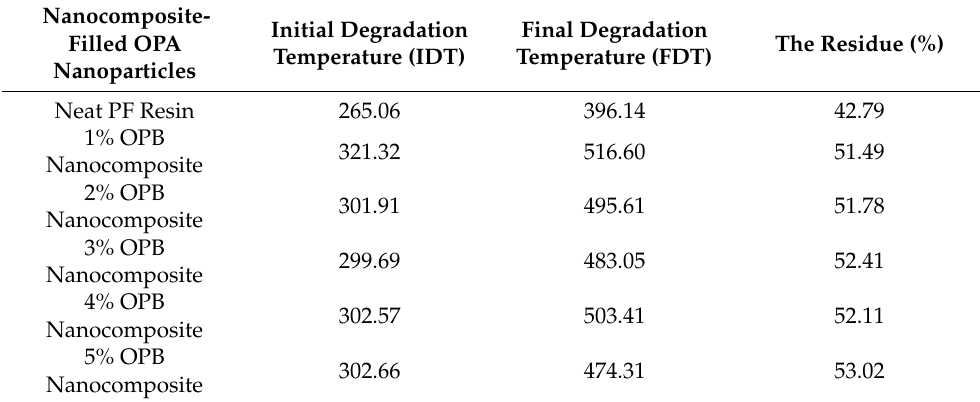
Table 1. Thermal properties of nanocomposite-filled OPA